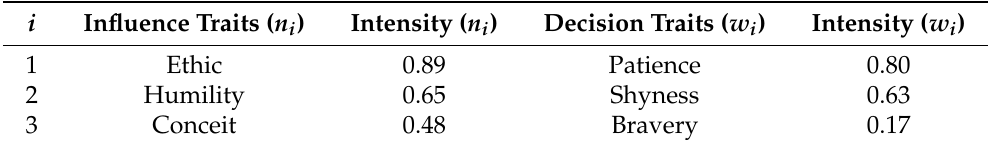
Table 7. The intensity of personality traits is classified as